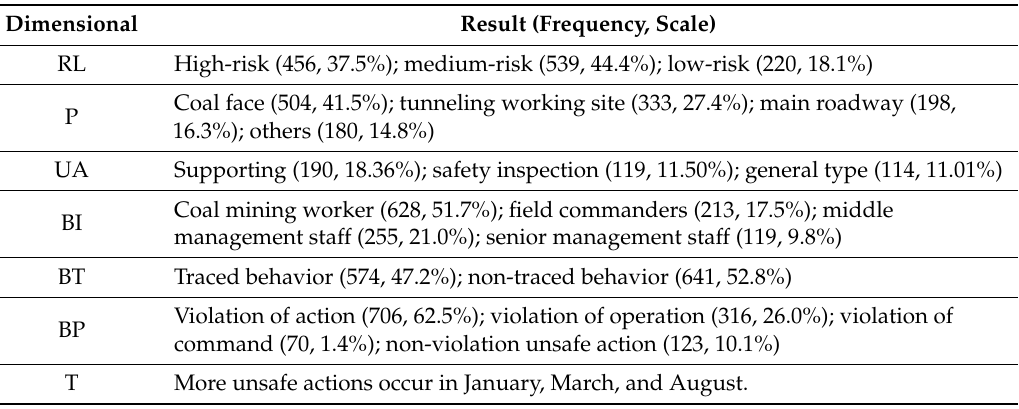
Table 1. Statistics of a single